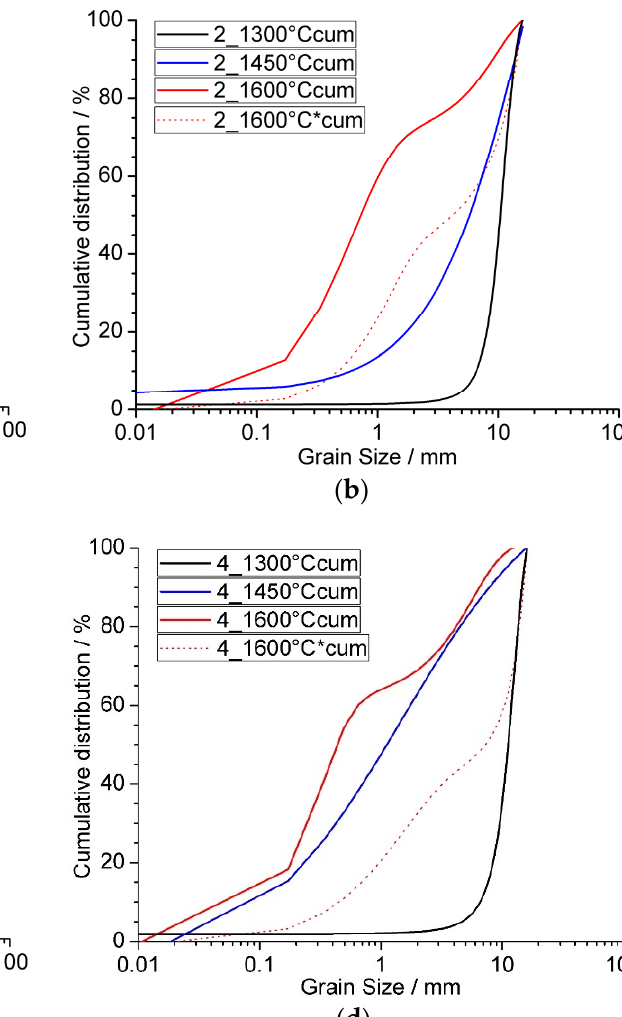
( d ) Figure 8. Cumulative curves after thermal and mechanical stressing of quartzites. ( a ) Quartzite Slovakia ; ( b ) quartzite Sweden ; ( c ) quartzite Poland ; ( d ) quartzite Ukraine . When comparing the changes in granulometry due to mechanical stress at 1600 °C, we noticed differences in the growth of fine-grained fractions in the samples. The calcu- lated HI (Formula (8)) and TSI (Formula (9)) indexes confirmed this stability trend (Fig- ure 9). Disintegration of the samples after thermo-mechanical stress was also reflected in